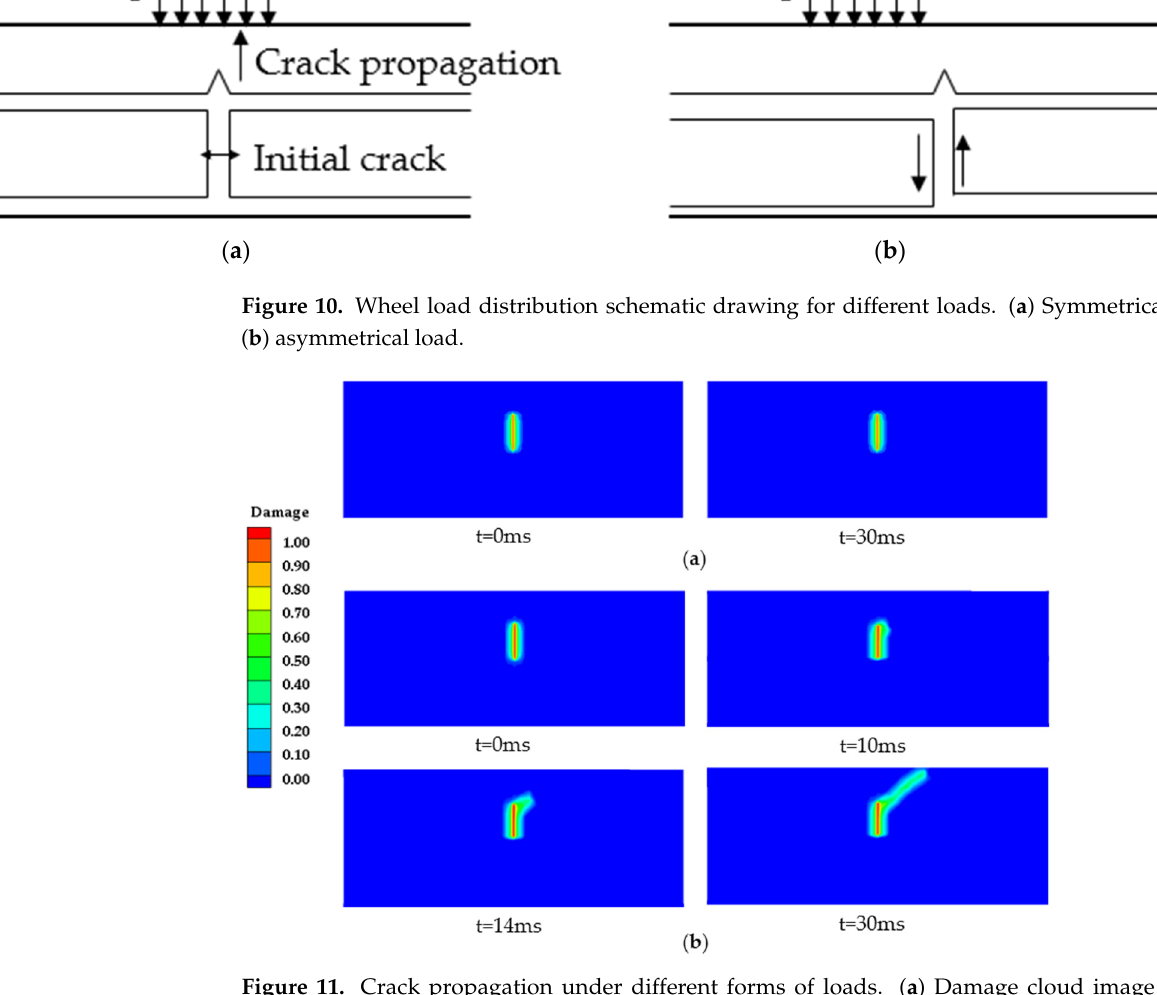
Figure 10. Wheel load distribution schematic drawing for different loads. ( a ) Symmetrical load; ( b ) asymmetrical load.